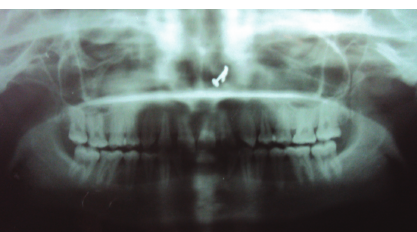
Figure 7: Orthopantomogram.